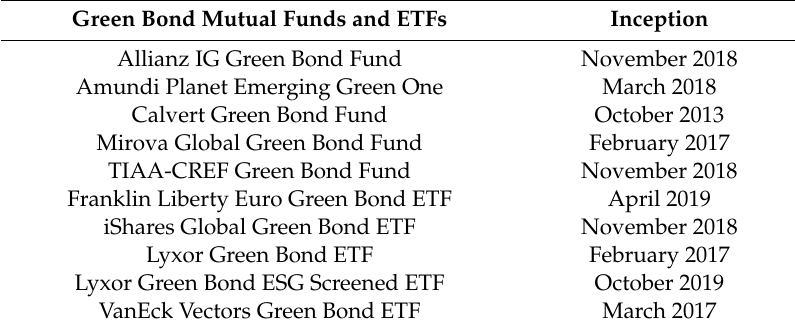
Table 2. Green bond mutual funds and